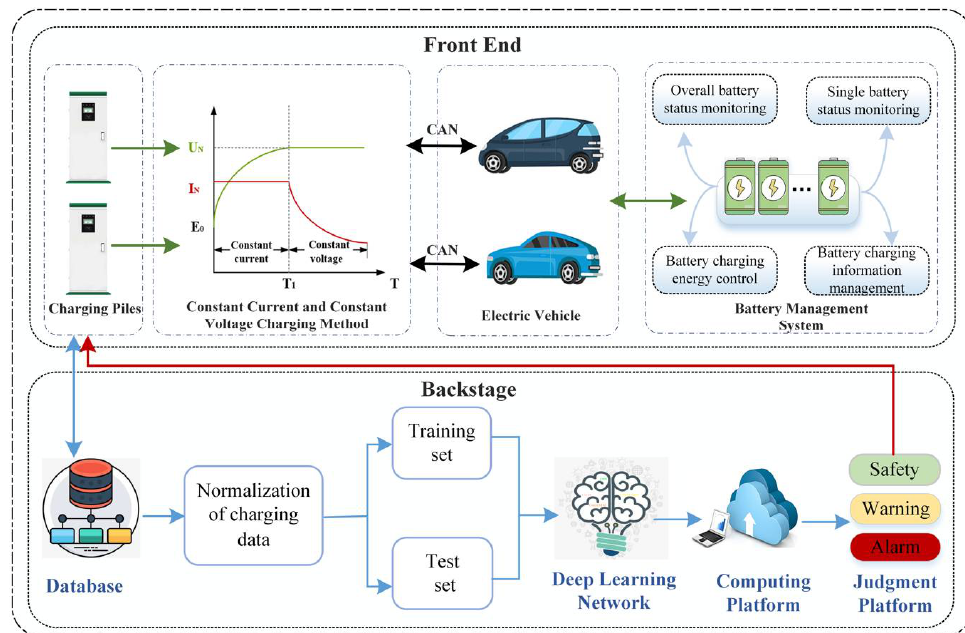
Figure 1. Diagram of charging platform system for electric vehicle.